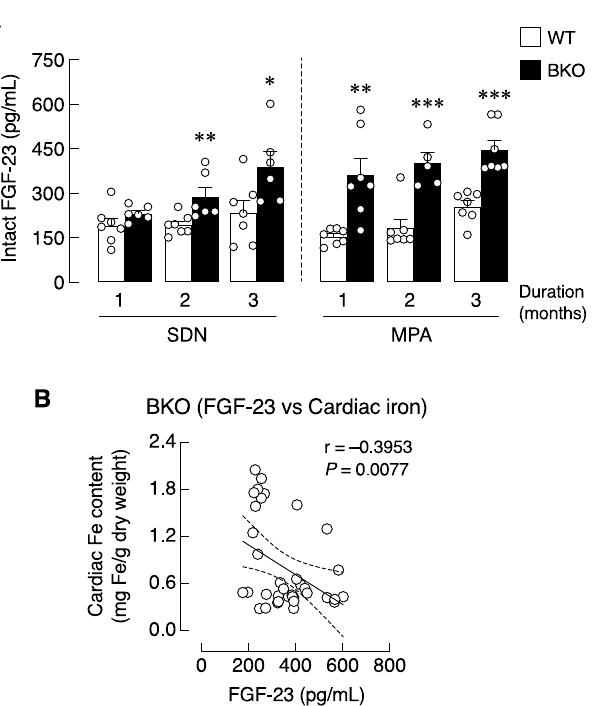
Figure 3. ( A ) Serum level of intact FGF-23 in β-globin knockout (BKO) and wild-type (WT) mice after mild- intensity physical activity (MPA) training for 1, 2, and 3 month(s) compared with corresponding sedentary (SDN) group. Values are means ± SE (n = 5–7; * P < 0.05, ** P < 0.01, *** P < 0.001 vs. corresponding age-matched WT group). ( B ) Correlation plot between serum intact FGF-23 and cardiac iron content. Dashed line represents the 95% confidence bands of the best-fit line. r, correlation coefficient. P , p-value of the